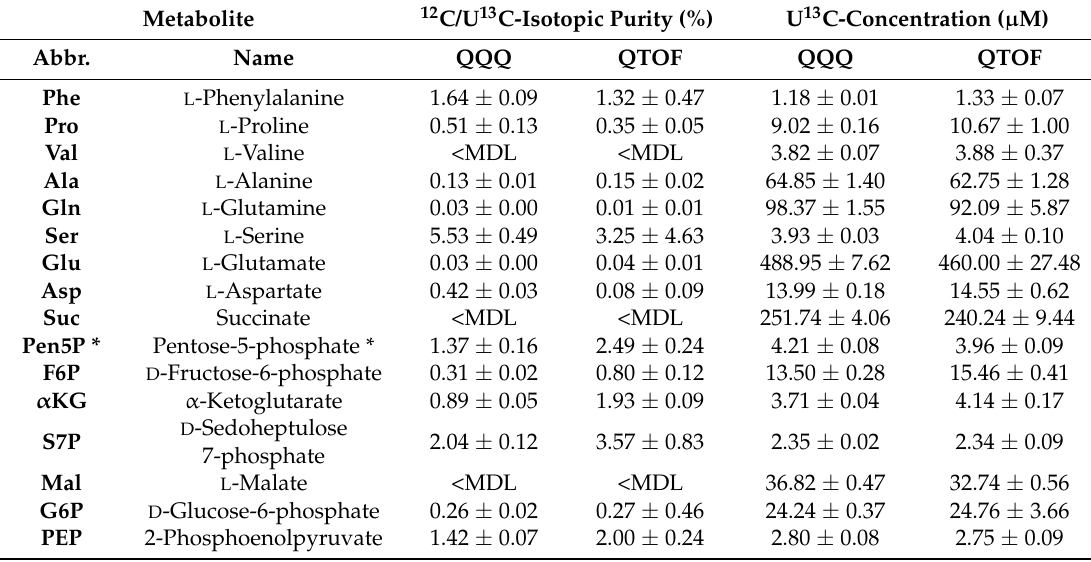
Table 3. Quality of U 13 C-labeled C. glutamicum extracts for IDMS using QQQ-MRM and QTOF-HRMS detection. See Tables S1–S4 for the full names of abbreviated metabolites.